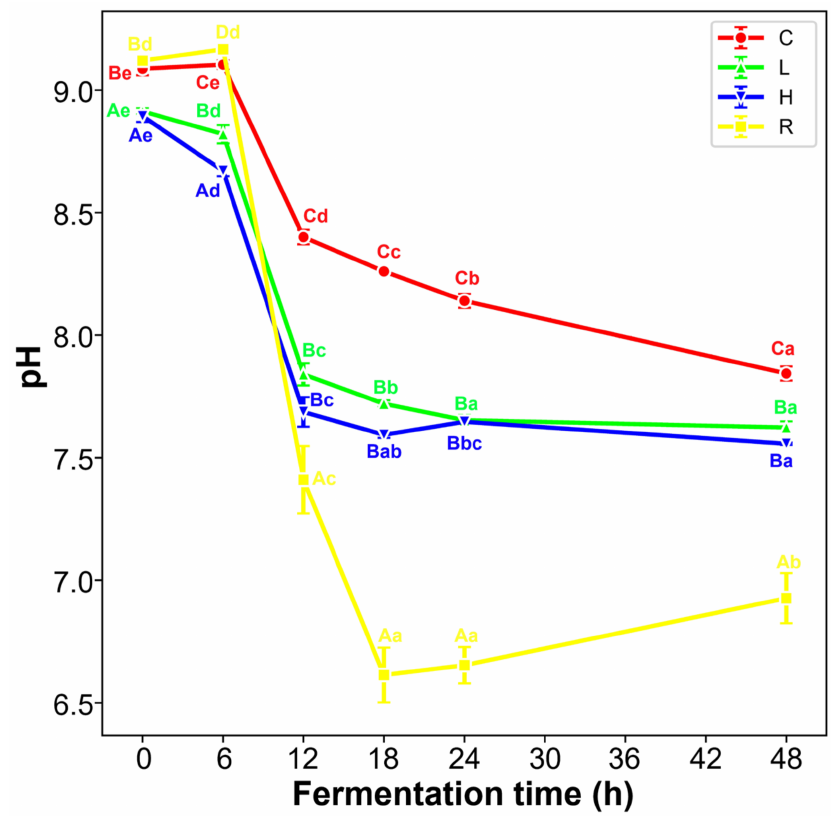
Figure 4. The pH changes in infant feces during fermentation. Different capital superscript letters indicate significant differences for each pH value in different groups, while different lowercase superscript letters indicate significant differences ( p < 0.05) for each pH value on different dates of sampling. C, blank group; L, low-dose group; H, high-dose group; R, positive control